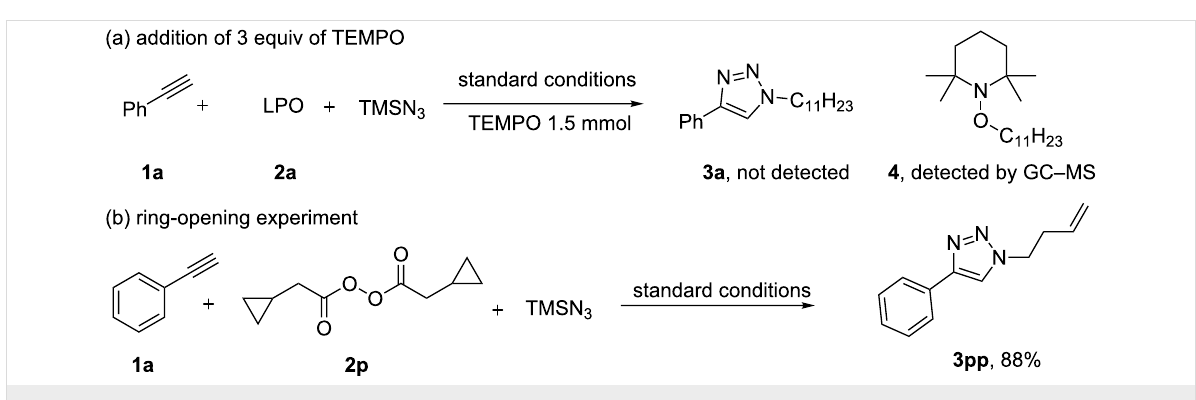
Scheme 4: Preliminary mechanistic